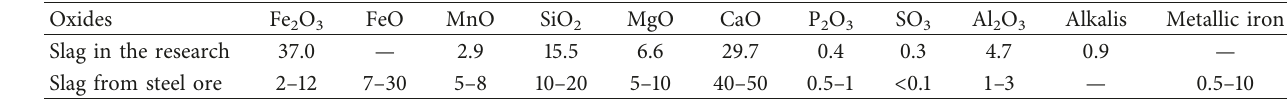
Table 3: Chemical composition of slag (%).